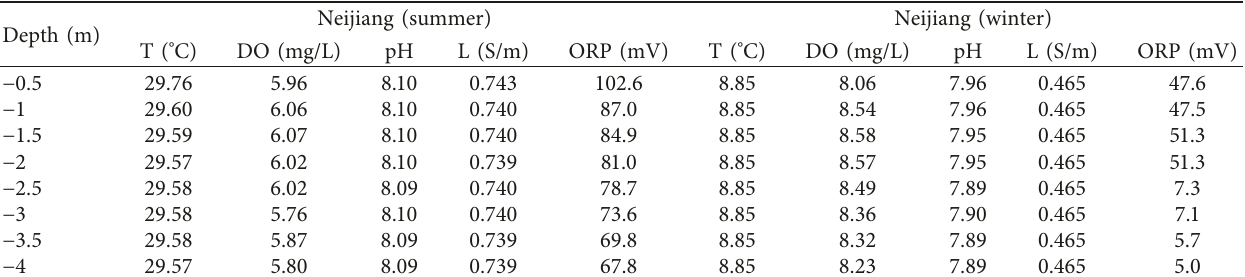
Table 2: Results on the physicochemical parameters of overlying water of Neijiang in summer and winter, Tuohe River. Depth